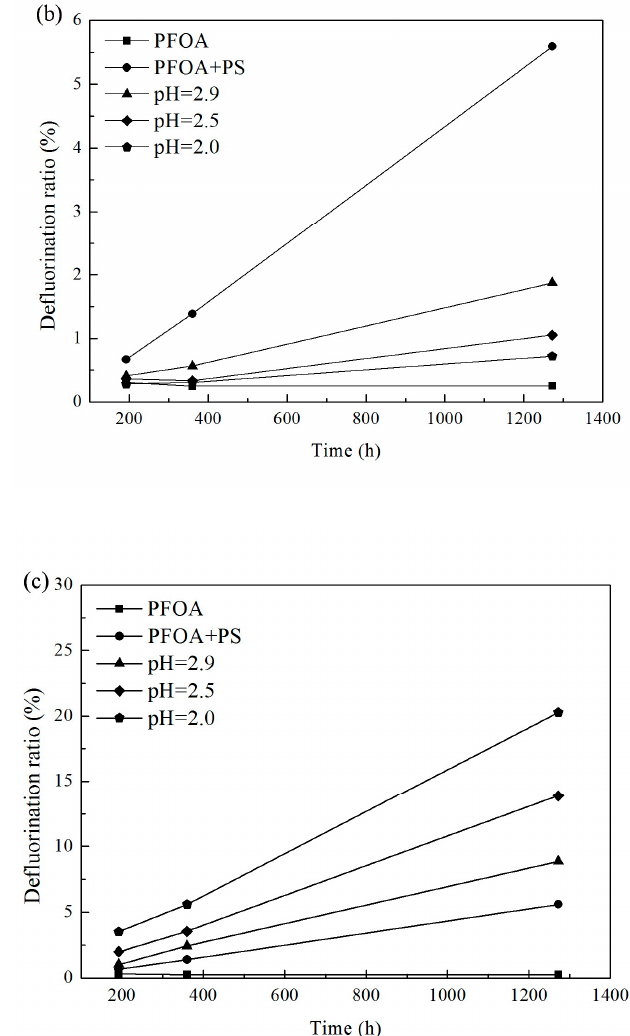
Figure 1. Effects of pH on the degradation of PFOA: ( a ) Solution pH was adjusted by NaOH and H 2 SO 4 from 1.8 to 12.0, [PFOA] 0 = 20 µ M; [persulfate] 0 = 2 mM, reaction temperature: 40 ˝ C, reaction